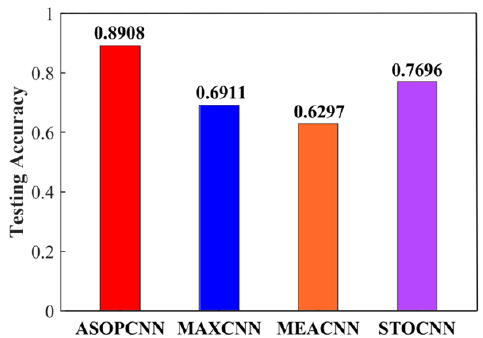
Figure 13. Accuracy of each model on the test set.